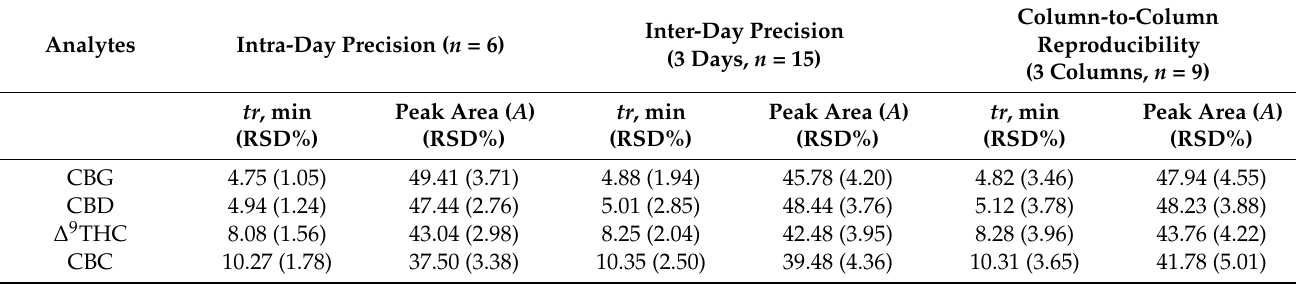
Table 1. Intra-day, inter-day repeatability and column reproducibility expressed as average values and RSD% for retention times ( tr ) and peak areas ( A ).